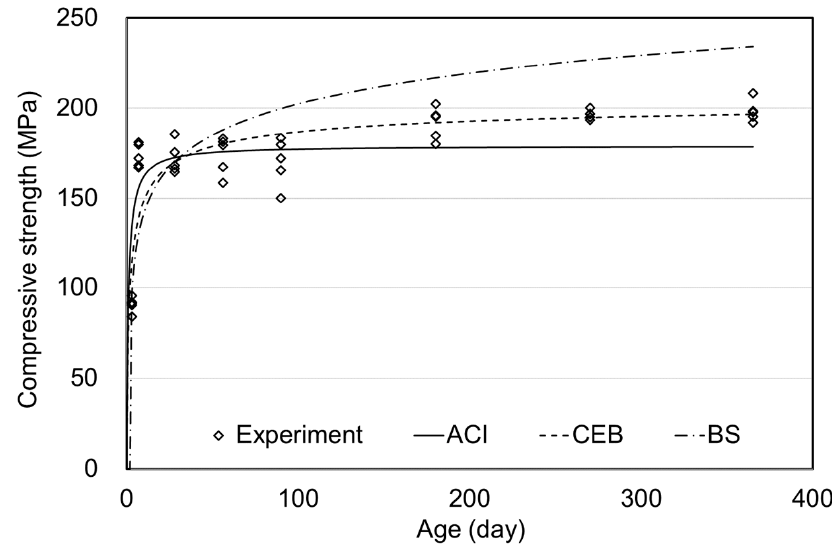
Figure 6. Comparative results of steam curing compressive strength. Table 3 and Figure 7 show the air curing experiment results and modified models. The modified equations of ACI and CEB(BS) were given as Equations (7) and (8).